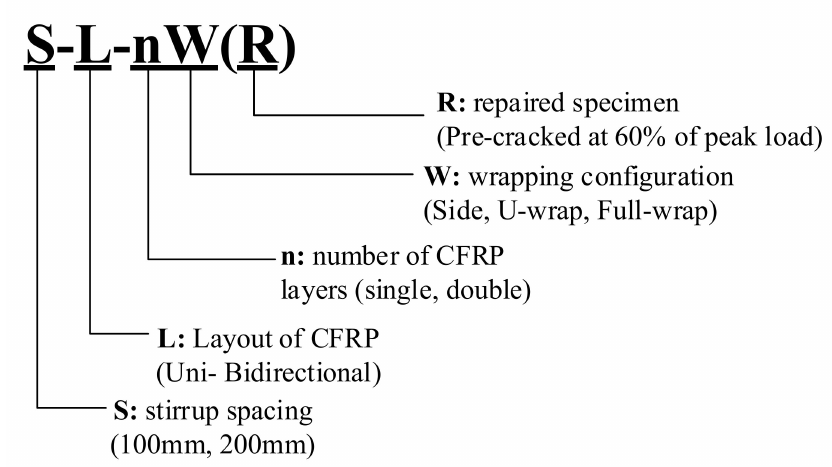
Figure 1. Nomenclature of test specimens.